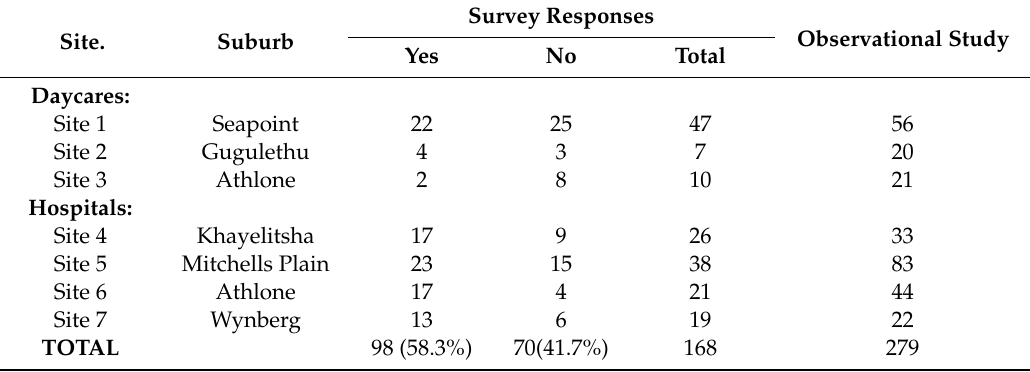
Table 1. Total number of survey responses and observed vehicles in study